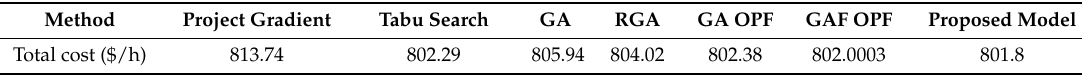
Table 1. Comparison of different methods to 30-bus power system model. GA: genetic algorithm; RGA: real genetic algorithm; OPF: optimal power flow.